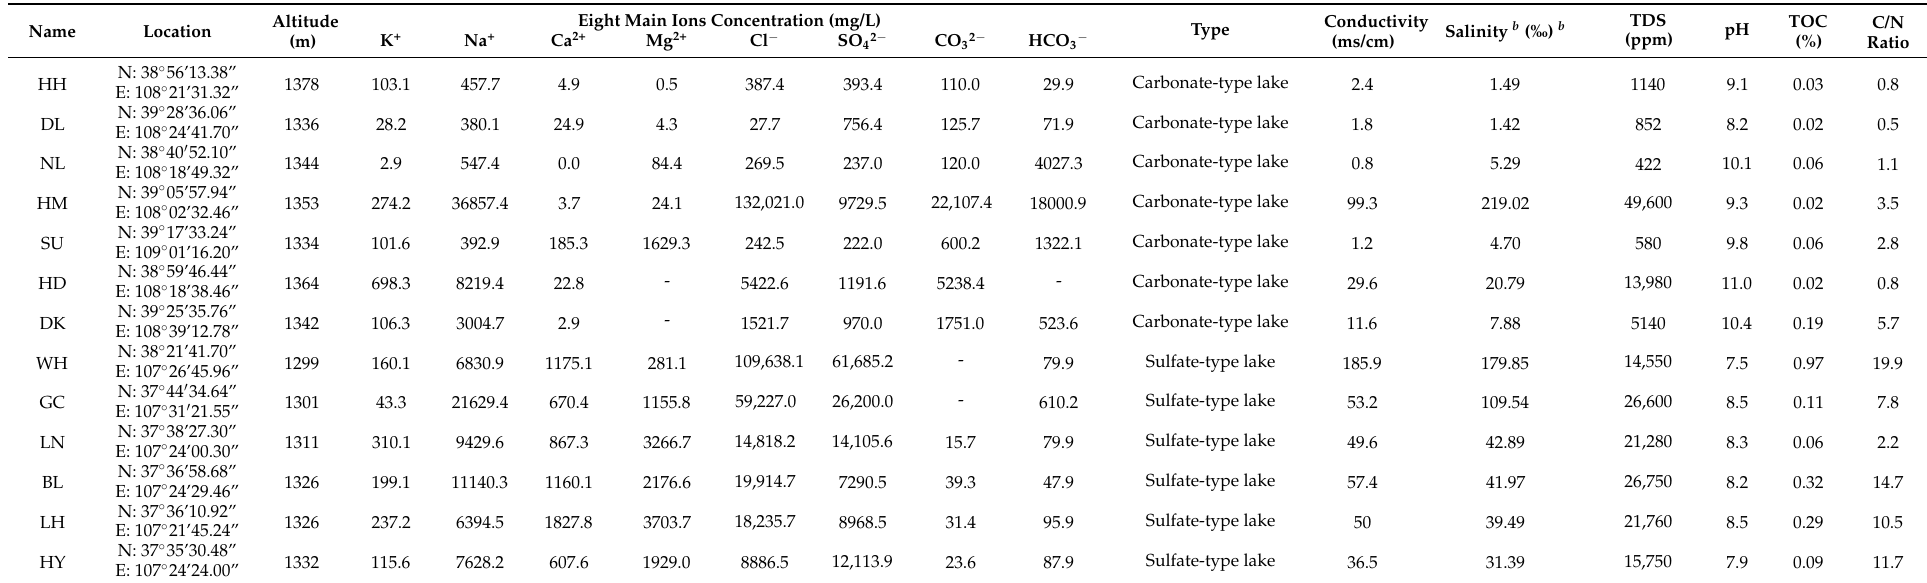
Table 1. Geochemical data from surface sediments of the 13 saline lakes in the Ordos